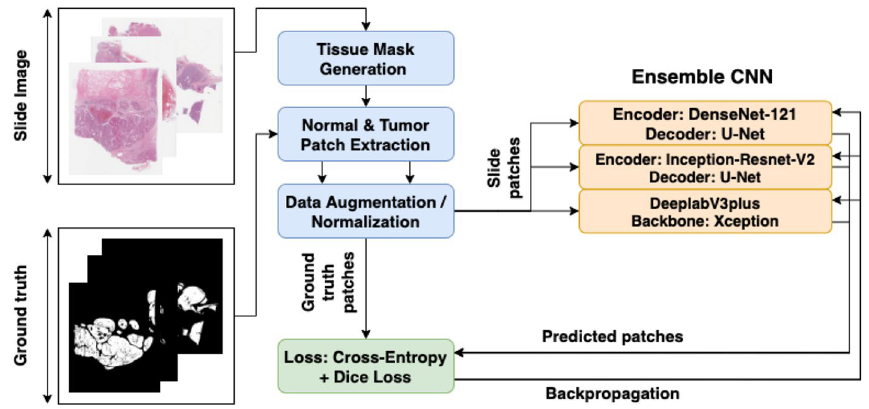
Figure 2. Overview of the tumour segmentation training pipeline. Drawn using draw.io